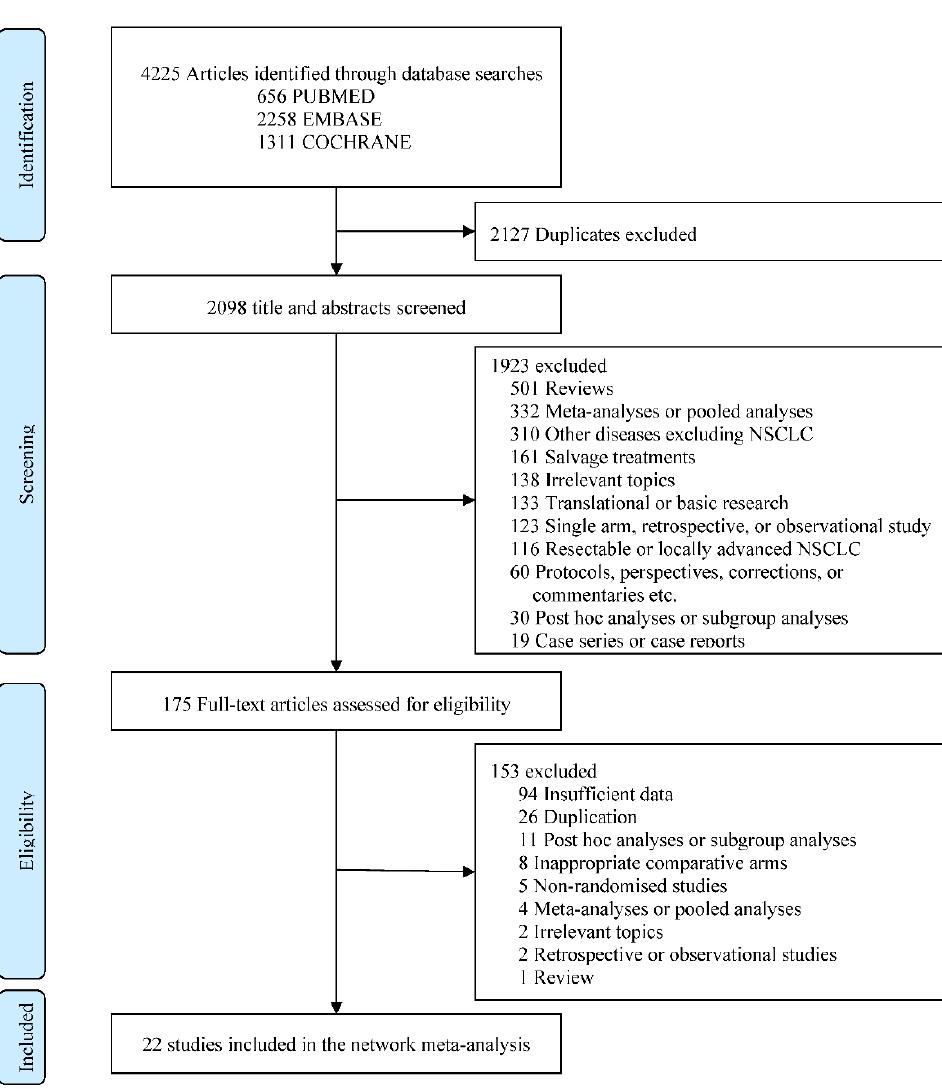
Figure 1. Preferred reporting items for systematic reviews and meta-analyses (PRISMA) flow diagram showing the selection process of studies included in Bayesian network meta-analysis.